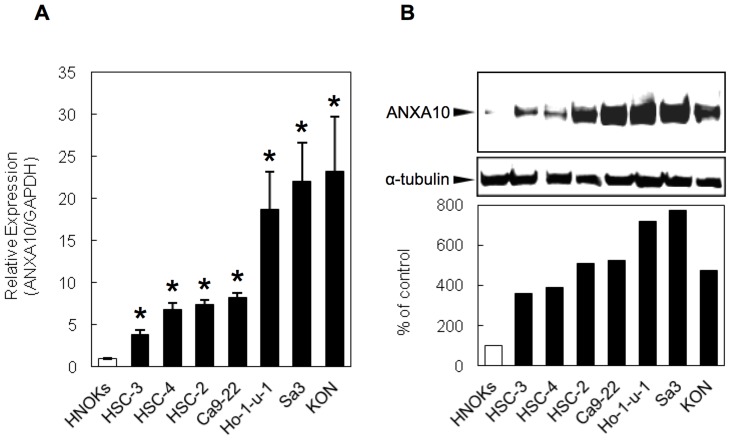
Evaluation of ANXA10 expression in OSCC-derived cellular lines.(A) Quantification of ANXA10 mRNA levels in OSCC-derived cellular lines by qRT-PCR analysis. Significant up-regulation of ANXA10 mRNA is seen in the seven OSCC-derived cellular lines compared with that in the HNOKs. Data are expressed as the means ± SEM of values from three assays (*p<0.05; Mann-Whitney U test). (B) Immunoblotting analysis of ANXA10 protein in the OSCC-derived cellular lines and HNOKs. ANXA10 protein expression (molecular weight, 37 kDa) is up-regulated in the OSCC-derived cellular lines compared with that in the HNOKs. Densitometric ANXA10 protein data are normalized to α-tubulin protein levels. The values are expressed as a percentage of the HNOKs.